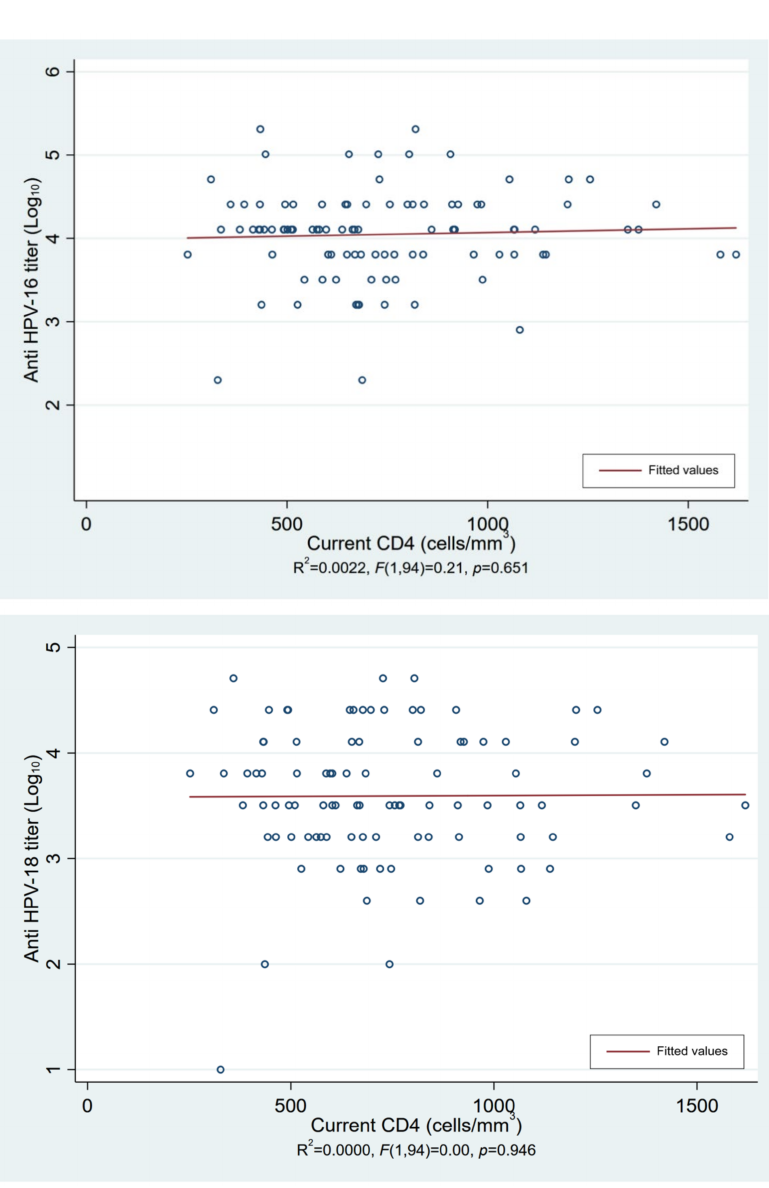
Figure 2. The correlation between CD4 cell count and anti-HPV-16 and -18 antibody response after